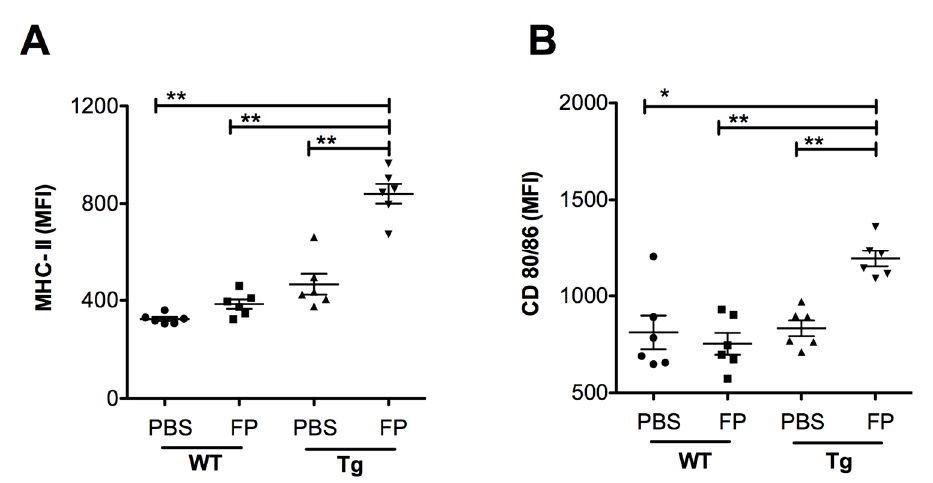
Figure 8. Trivalent-FP induced APC activation in the NALT of Tg mice: groups of WT (wild type) and Tg (transgenic) mice were immunized intranasally with 20 µ L PBS or 20 µ g Trivalent-FP (in 20 µ L PBS). Twenty-four hours after immunization, mice were euthanized and their NALT cells were isolated. Cells were stained with CD11b-PE-Cy7, CD11c-APC, MHC-II-FITC, CD19-PE, CD80-PerCP-Cy-5.5, CD86-PerCP-Cy-5.5, and Fixable Viability Dye eFluor 780. Viable cells were gated on CD19 − and MHC-II + and the mean fluorescence intensity (MFI) of MHC-II ( A ) and CD80 / 86 ( B ) was calculated. Mean ± SE of data from two independent experiments is shown ( n = 6 / group, * p = 0.001), ** p = 0.01. Statistical significance between indicated groups was evaluated by Mann–Whitney nonparametric test.